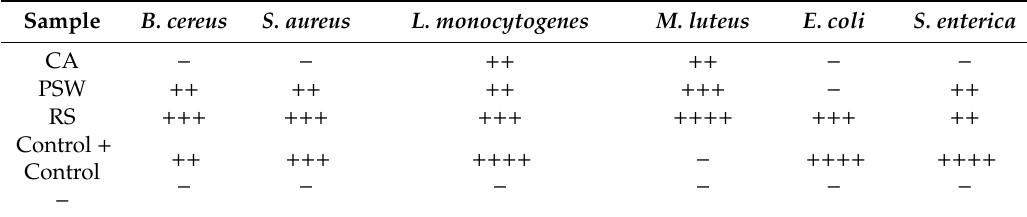
Table 3. Antimicrobial activity of PSW, CA, RS (extracts) and controls ( + and − ).